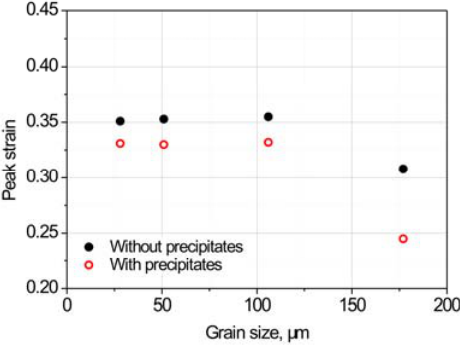
Figure 8. Peak strains of specimens of different grain sizes with and without precipitates.